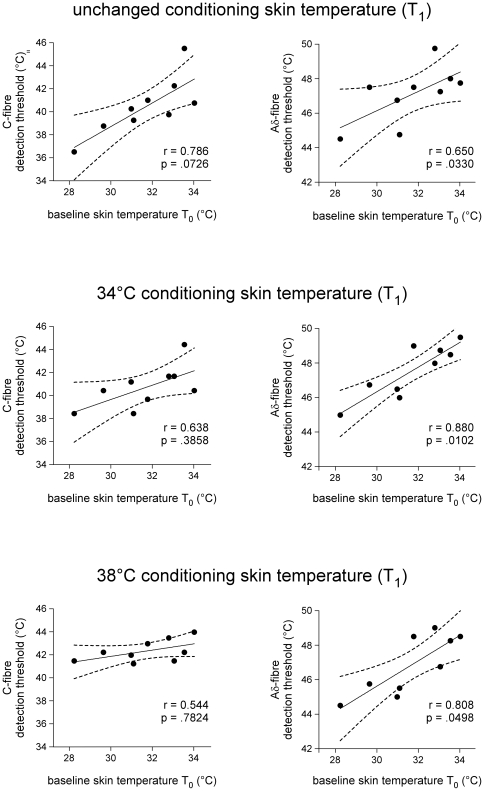
Correlation between baseline skin temperature (T0) measured immediately before trial onset and the thermal detection threshold of the behavioural responses triggered by Aδ- and C-fibre input, in each of the three experimental conditions (T1 = unchanged, T1 = 34°C and T1 = 38°C) (Pearson's correlation coefficient, two-tailed p-values, adjusted for six comparisons using the Bonferroni correction).Note the positive relationship between baseline skin temperature (T0) and the Aδ-fibre threshold, in particular, when the stimulated area was brought for two seconds to T1 = 34°C and T1 = 38°C prior to applying the test stimulus.